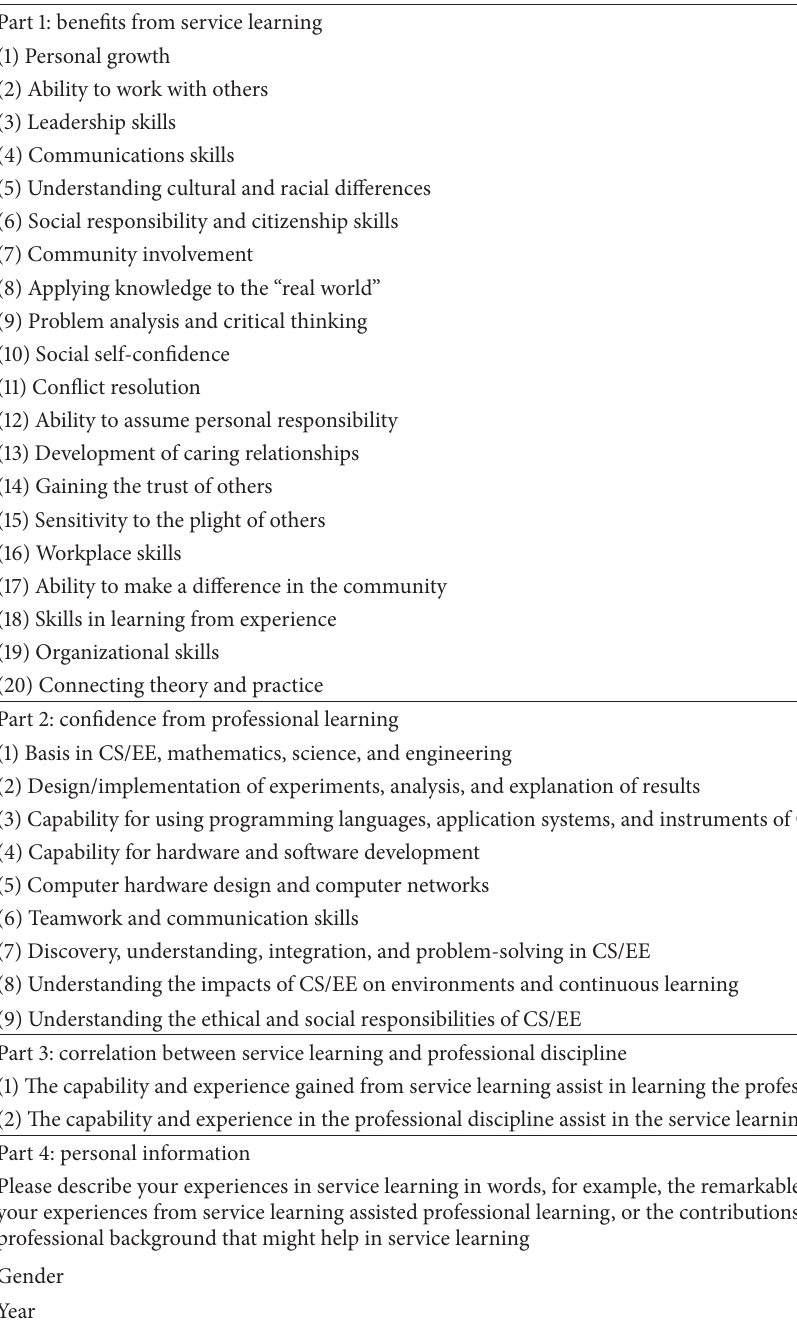
Table 1: The structure of the questionnaire.